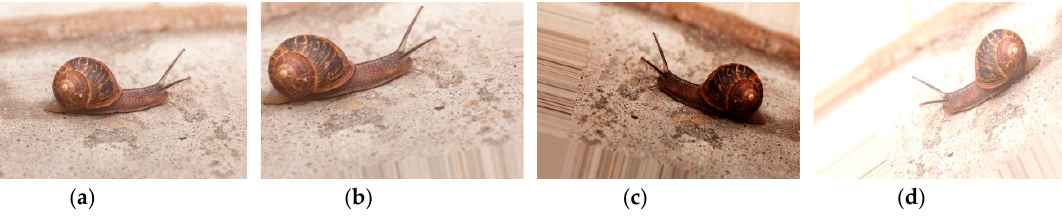
Figure 2. Results of the proposed data augmentation method: ( a ) original image; ( b–d ) generated images.